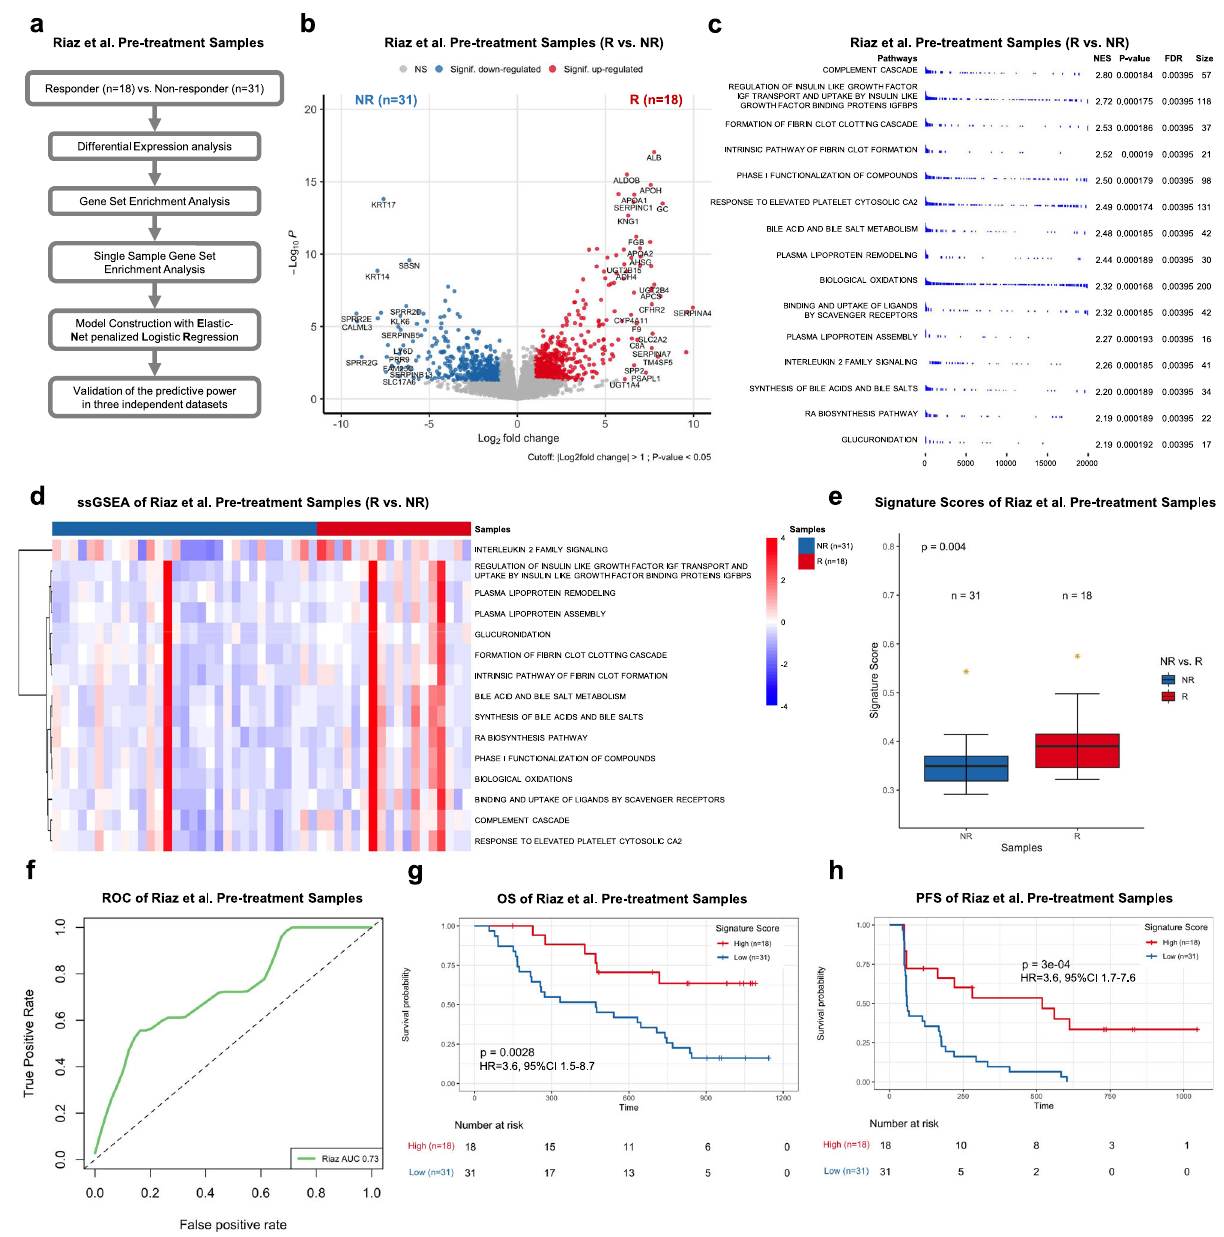
Fig. 2 Pathway-based super signature for pre-treatment samples. a The computation pipeline of model construction based on pre-treatment samples in the Riaz et al. cohort. b The volcano plot of differential gene expression analysis between pre-treatment responders (R) and nonresponders (NR) in the Riaz et al. cohort. Log2Fold change (FC) was calculated. The two-sided Wald test was implemented to test if no differential expression between responder and nonresponders. The blue dots represent signi fi cantly downregulated (Signif. downregulated) genes (log2Fold Change < − 1, P -value < 0.05). The red dots represent signi fi cantly upregulated (Signif. upregulated) genes (log2Fold Change > 1, P -value < 0.05). The gray dots represent nonsigni fi cant (NS) genes. c GSEA results of 15 top ranked candidate pathways. Normalized Enrichment Score (NES) and the size of leading-edge geneset are calculated. The permutation based P -value shows the statistical signi fi cance of the enrichment score. The number of permutation is 10,000. False discovery rate (FDR) is the estimated probability that the normalized enrichment score represents a false positive fi nding. d The heatmap of ssGSEA values of pre-treatment responders (R) and nonresponders (NR) in the Riaz et al. cohort. Nonresponders are presented with the number of samples on the left side, and responders are presented with the number of samples on the right side. FDR-corrected two-sided Welch t -test was conducted to compare ssGSEA values between R and NR samples, only FDR < 0.05 showed here. e The boxplot of pre-treatment sample ’ s Pathway-based super signatures (PASS-PRE) signature score of responders (R) and nonresponders (NR) in the Riaz et al. cohort. The P -value was computed via a one-sided rank-sum test. Boxplot center lines indicate median, box edges represent the interquartile range, whiskers extend to the minimum and maximum, and the outliers are plotted individually using the ‘ * ’ symbol. f ROC and AUC of PASS-PRE on the pre-treatment samples in the Riaz et al. cohort. g, h The Kaplan – Meier survival analysis of overall survival (OS) ( g ) and progression-free survival (PFS) ( h ) of pre-treatment samples in the Riaz et al. cohort. The two-sided log-rank test compared high and low subgroups based on the mean of pre-treatment samples odd ratio as cutoff. Hazard ratio (HR) was calculated and shown with con fi dence interval (CI). Source data are provided as a Source Data fi le.